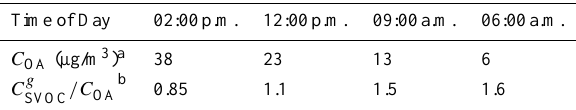
Table 2. The organic aerosol mass and relative semivolatile gas- phase concentrations for the time periods considered from Dzepina et al.